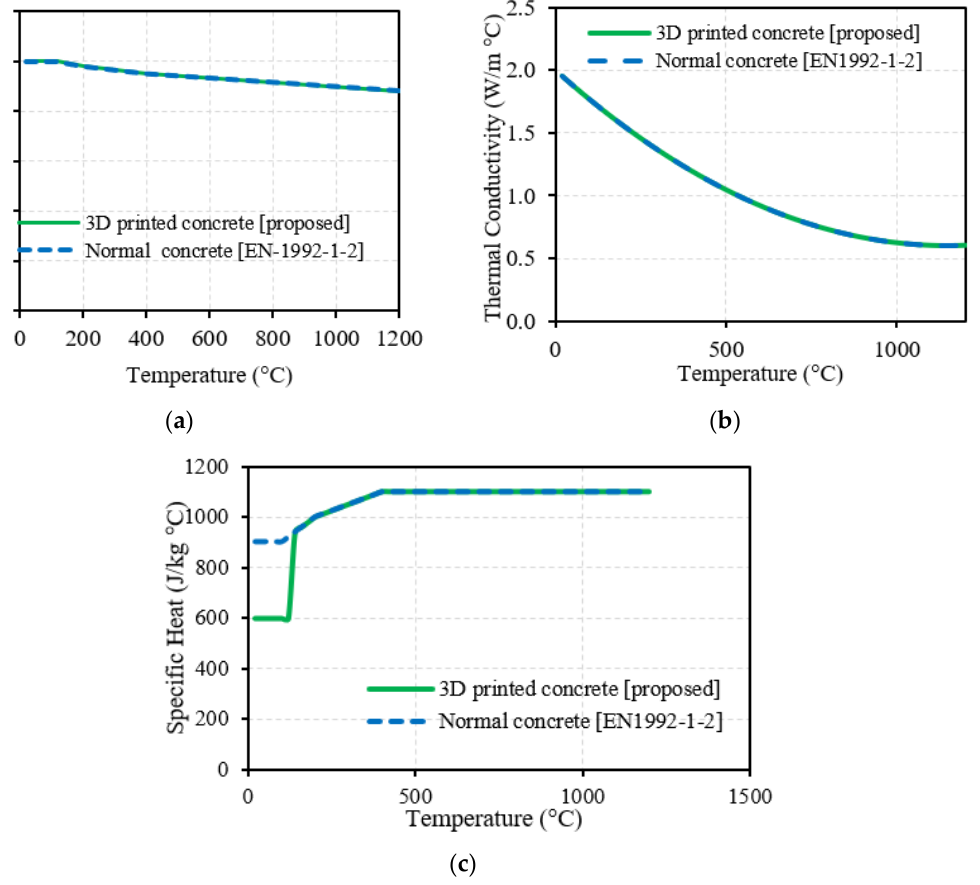
Figure 3. Thermal properties of 3D-printed concrete with increasing temperature: ( a ) relative density; ( b ) thermal conductivity; ( c ) specific heat [30].